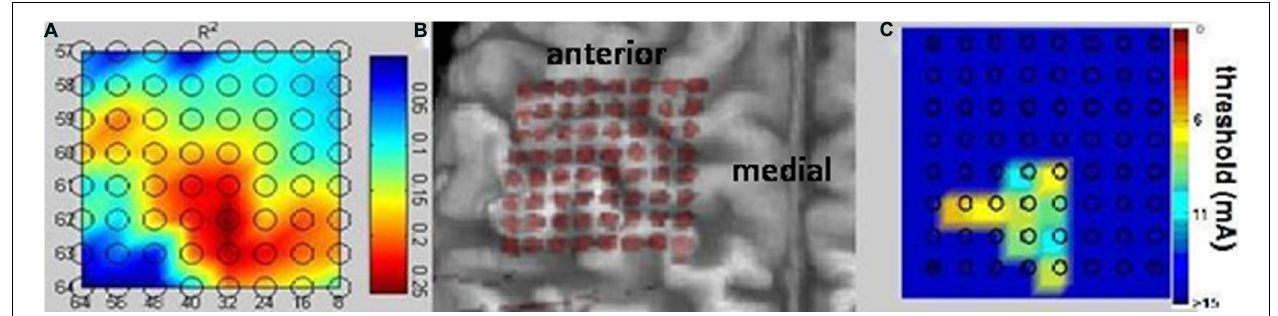
FIGURE 4 | Bidirectional epidural interface. Projection of the implanted 64 contact electrode grid on a three-dimensional reconstruction of the patient’s MRI cortical anatomy revealing the correct intraoperative positioning of the epidural implant without direct visualization of the cortical surface during surgery (B). Physiological mapping confirms the implantation on the area of the sensorimotor cortex related to phantom hand movements and